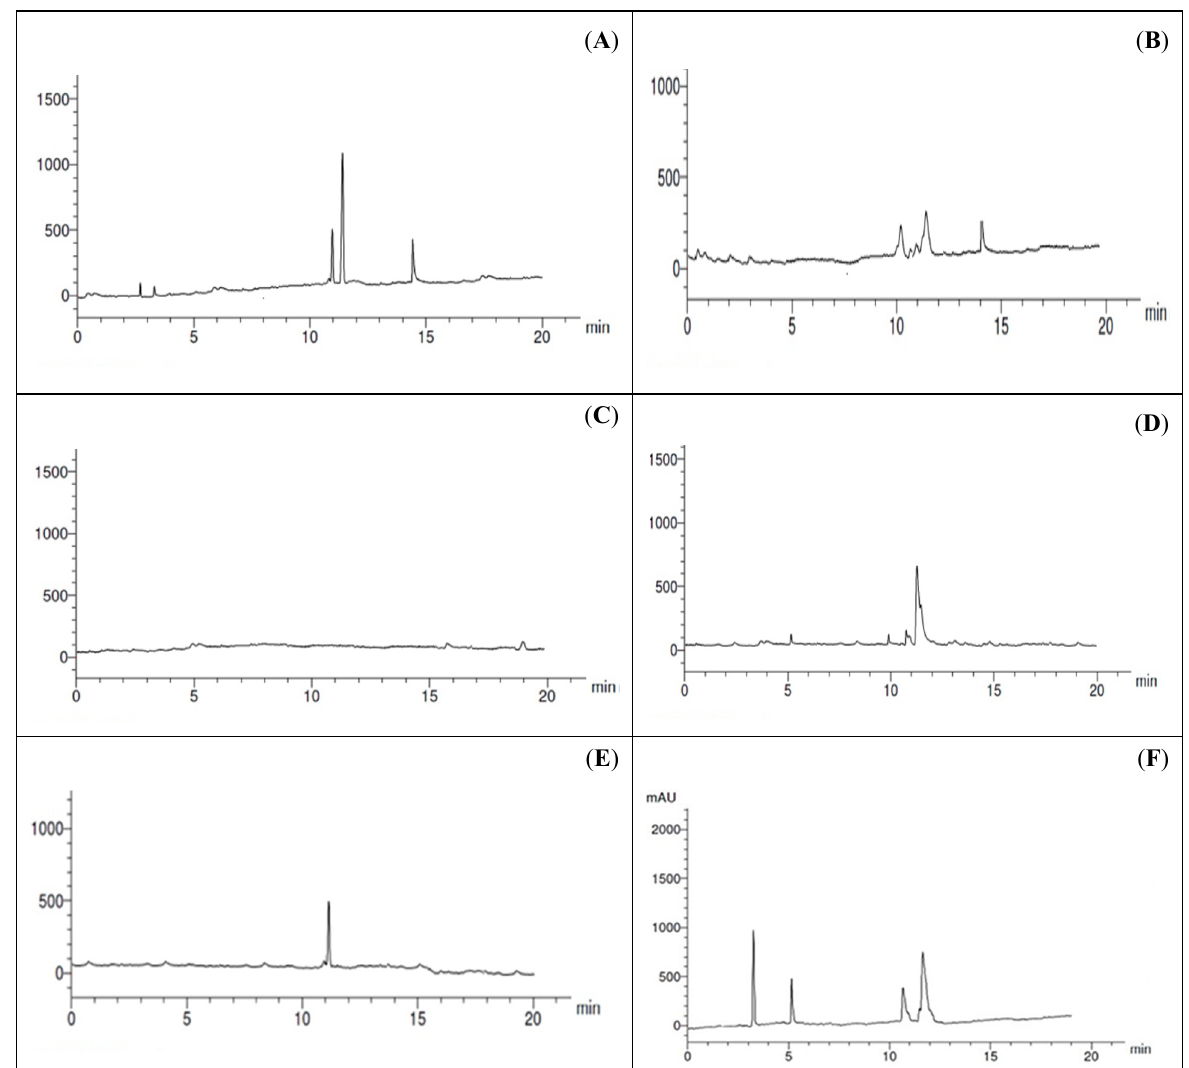
Figure 5. HPLC analysis of Alternaria culture extracts for mycotoxin detection: A. alternata ( A ); A. citri ( B ); A. brassicicola ( C ); A. radicina ( D ); A. tenuissima ( E ); toxin standard ( F ); AOH, AME, ALT, TA, respectively.